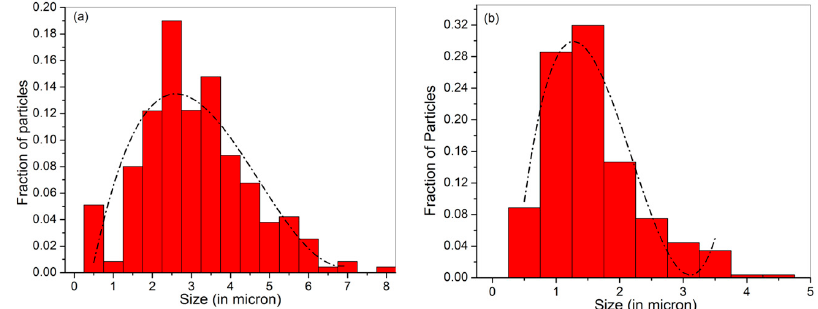
Figure 3. Particle size distribution of Al 2 Nd particles in Mg-4Al-1Nd alloy ( a ) as-cast condition, and ( b ) aged at 180 °C for 24 h.